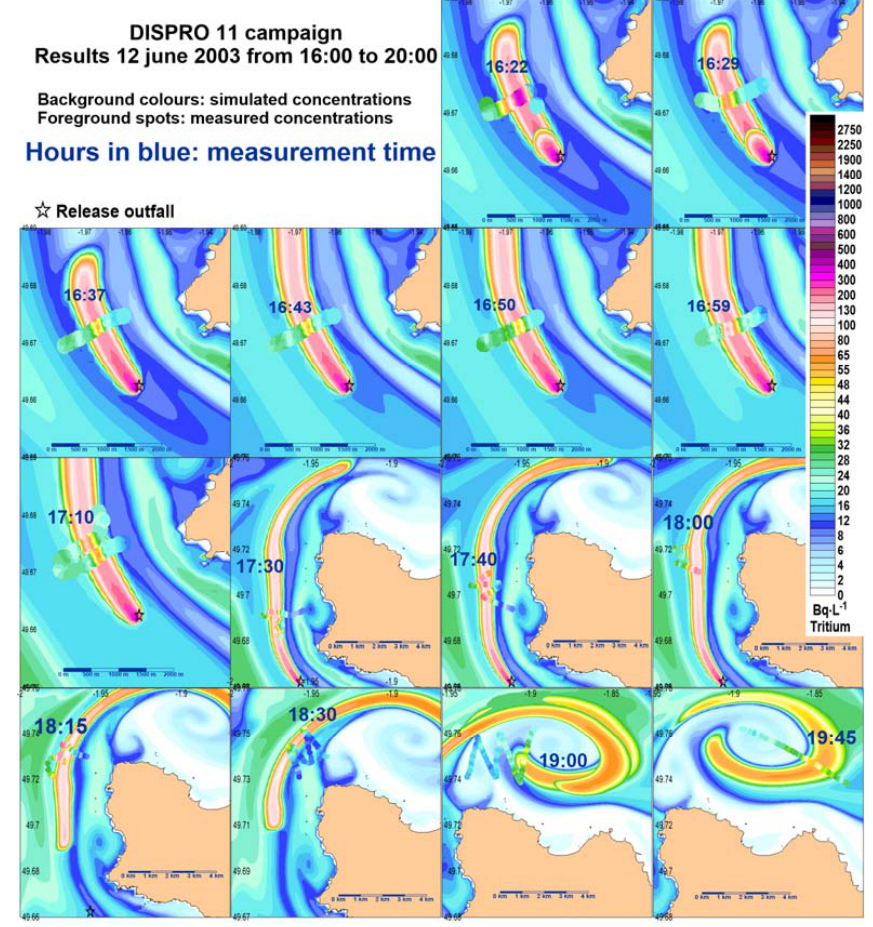
Figure 9. Example of a comparison between the measured and simulated dispersion during 4 h after release, from 16:22 to 19:45 adapted from [25].